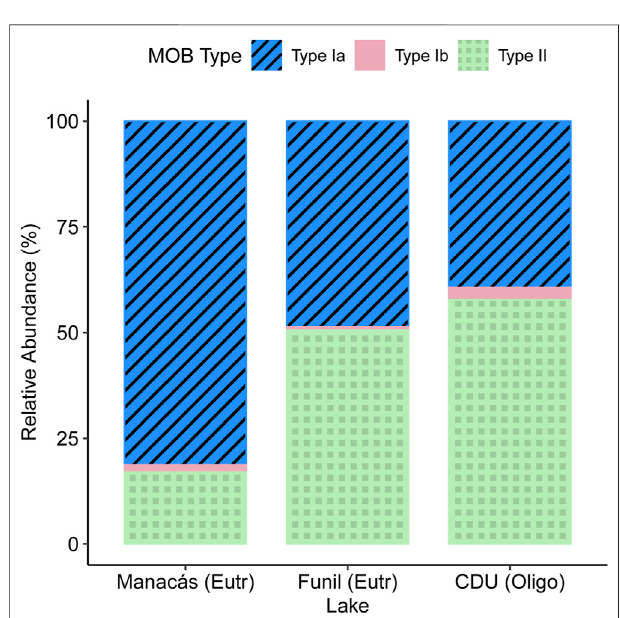
FIGURE 3 | proportional abundance of different types of MOB per lake based on qPCR copy number of the pmoA gene at the end of microcosm incubations. Different colours represent different types of MOB, n =